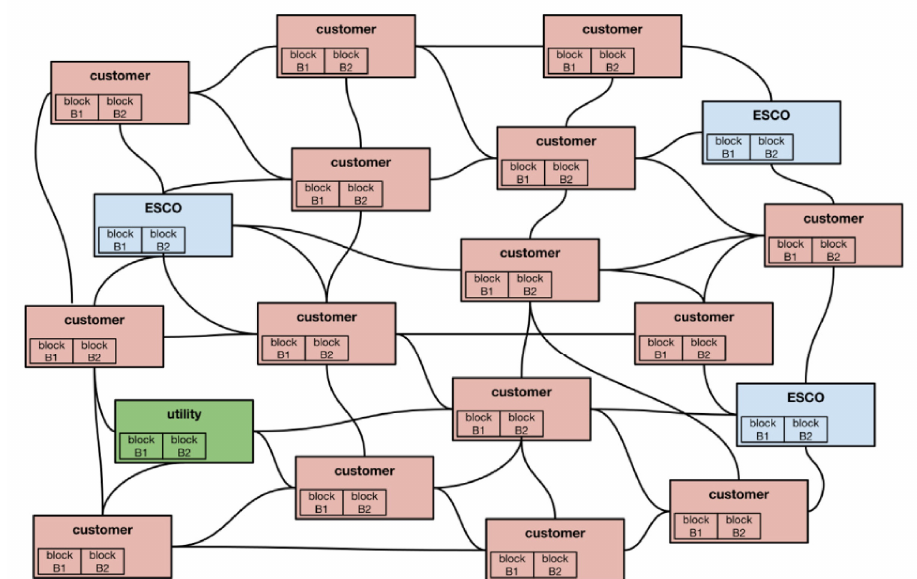
Figure 4. A conceptual diagram for a blockchain-based local energy market including the local utility and third-party energy service companies (ESCOs), adapted from